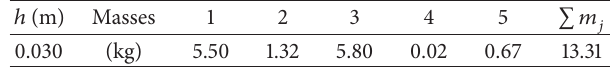
Table 9: Optimal design variables results (Case 2A).